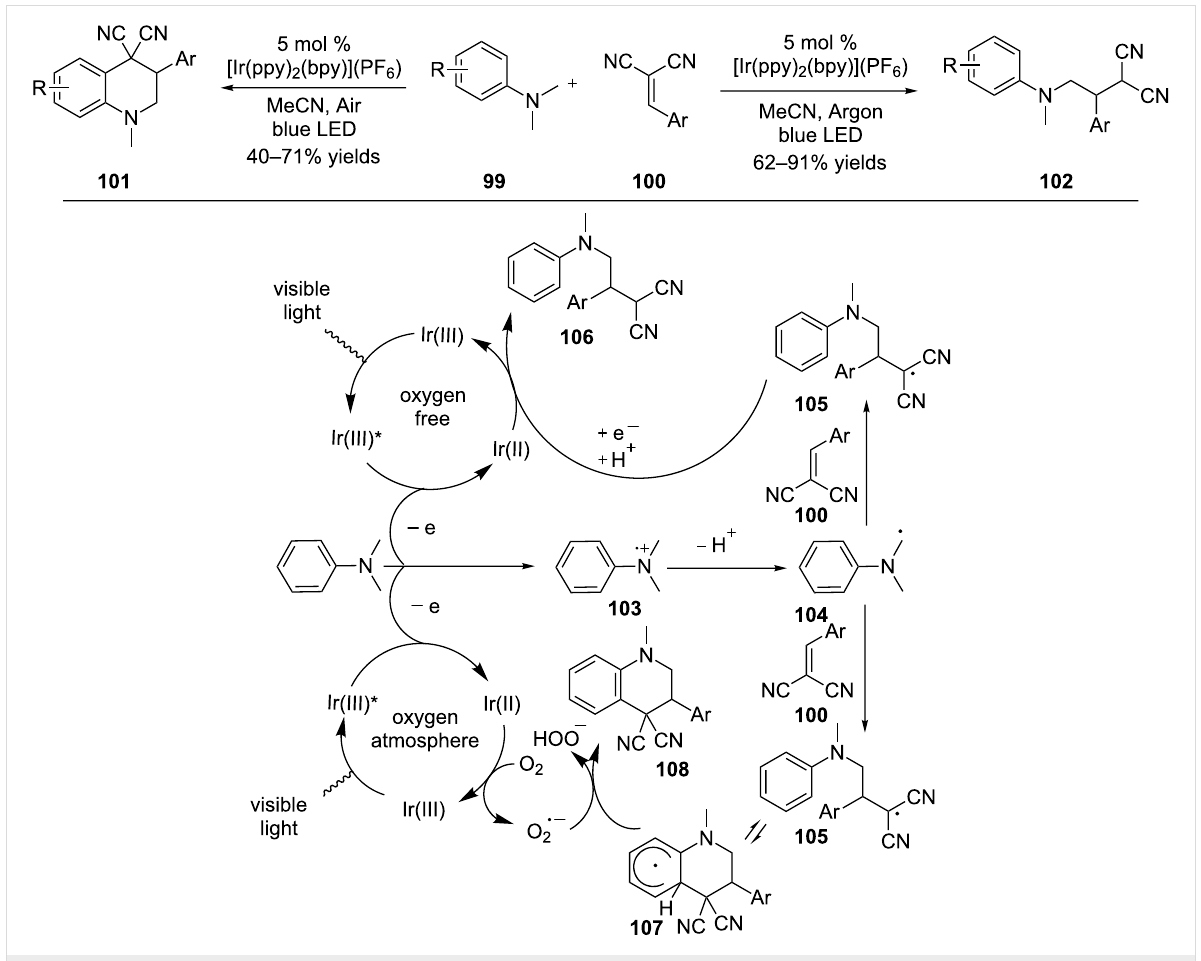
Scheme 25: Oxygen switch between two pathways involving α -amino radicals.